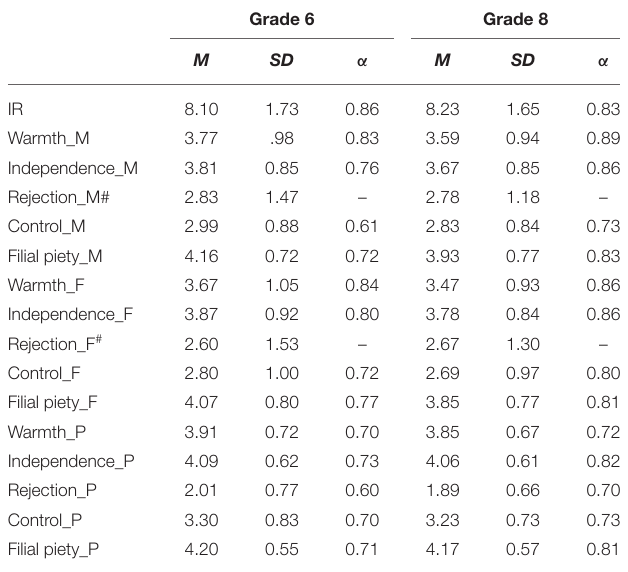
TABLE 1 | Descriptive statistics and reliabilities (Cronbach’s α